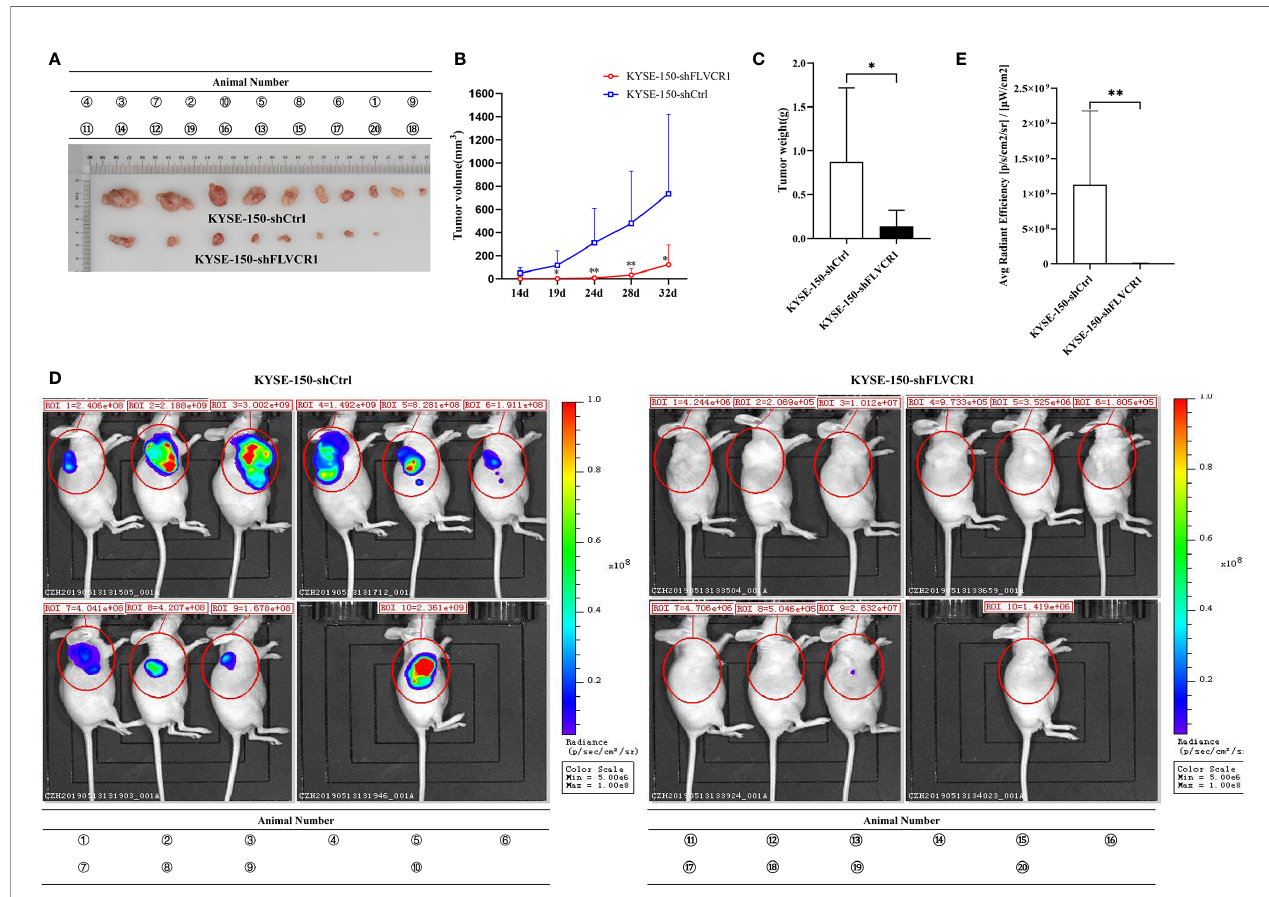
FIGURE 4 | FLVCR1 knockdown retarded tumor growth in vivo. (A) KYSE-150-shFLVCR1 cells generated smaller tumors in nude mice than the KYSE-150-shCtrl cells. (B) The growth curve showed that FLVCR1 knockdown suppresses growth. (C) KYSE-150-shFLVCR1-formed tumors had signi fi cantly lighter weight than KYSE-150-shCtrl cell-formed tumors. (D) In vivo imaging of tumor-bearing mice. (E) Seriously weakened fl uorescent radiant ef fi ciency was found in KYSE-150- shFLVCR1 cell-injected mice compared to that of control mice. Data were represented as the mean ± SD. *P<0.05,